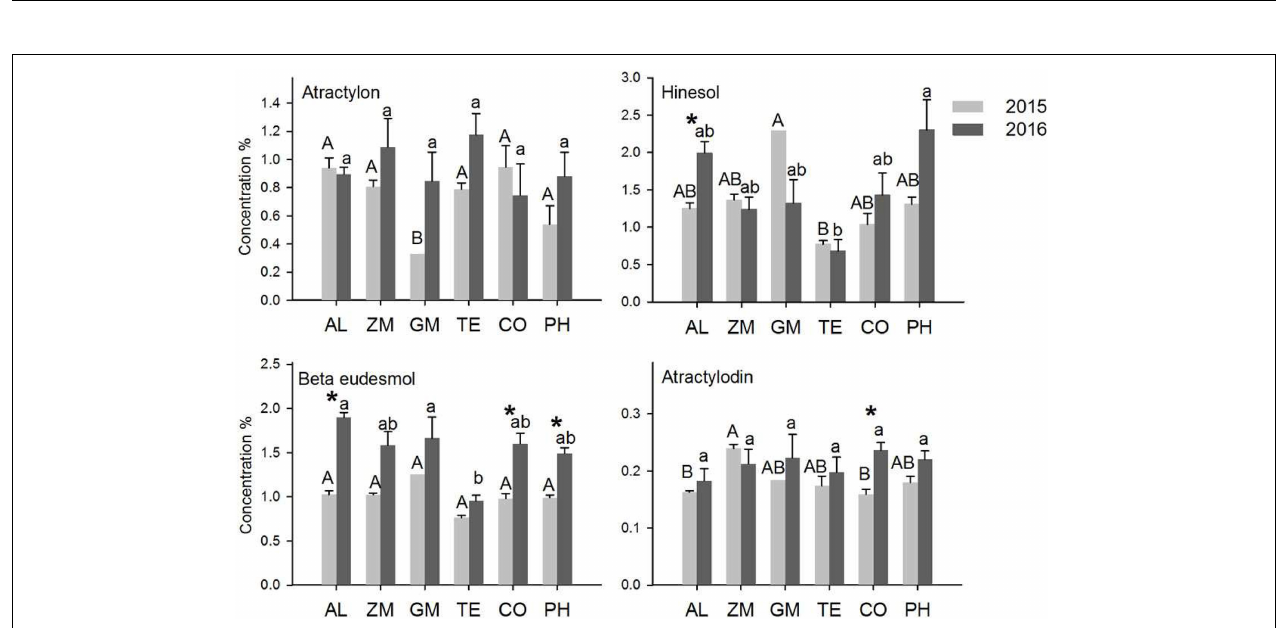
FIGURE 3 | Effect of different intercropping treatments on branch number (A) , bud number (B) , height (C) , and fresh weight (D) of A. lancea in 2015 and 2016. Different lowercase letters indicate significant differences at the 5% significance level.